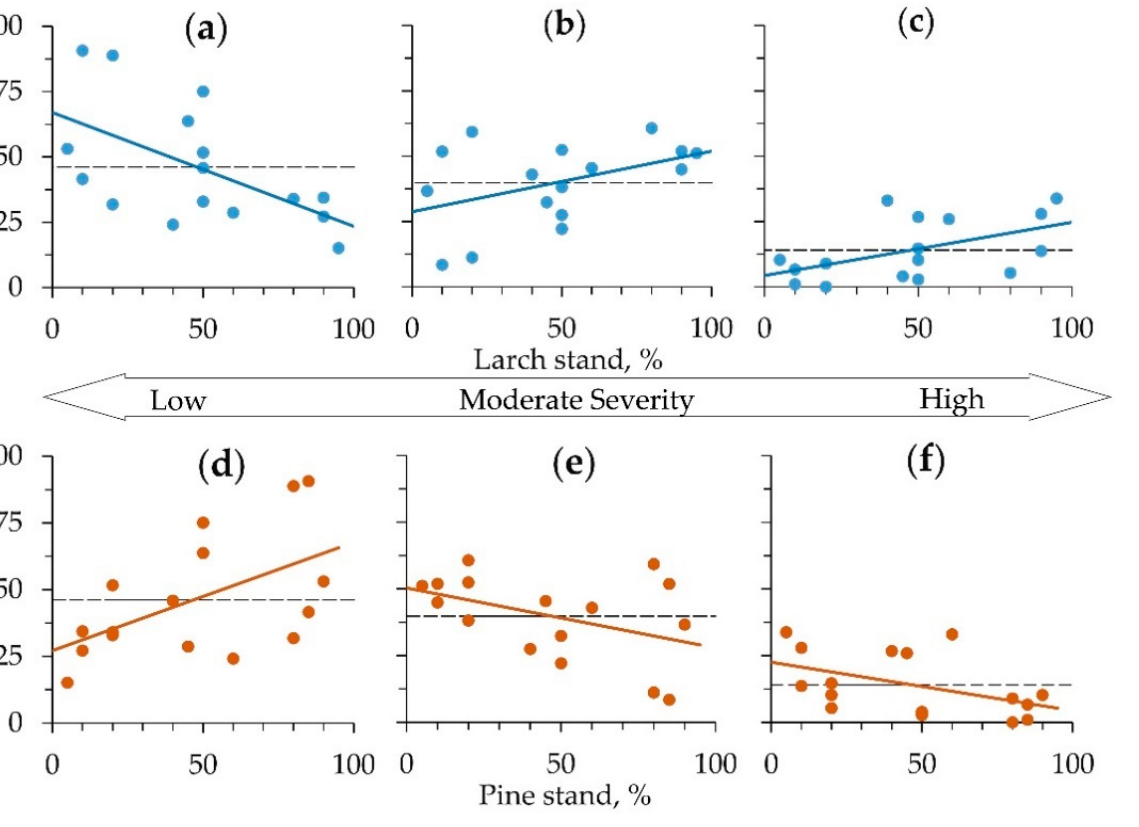
Figure 4. The dNBR for a sample of fire events in mixed larch-pine stands, where the percentage of larch dominance decreased from 95% to 5% ( a – c ), while the proportion of pine increased from 5% to 95% ( d – f ), respectively. The dashed line indicates the average values of low ( a , d ), moderate ( b , e ), and high ( c , f ) fires severity.